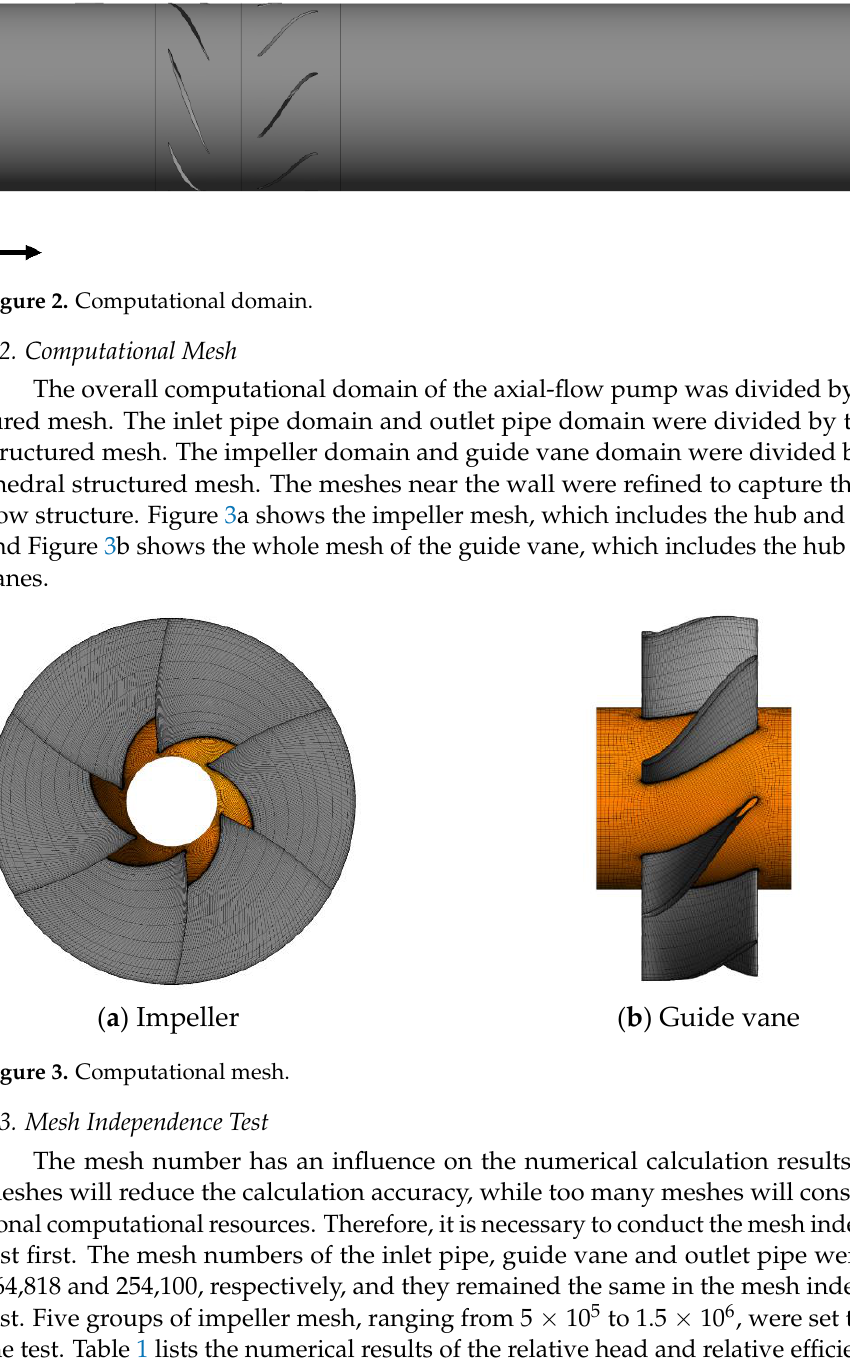
Table 1. Independence test of mesh number.